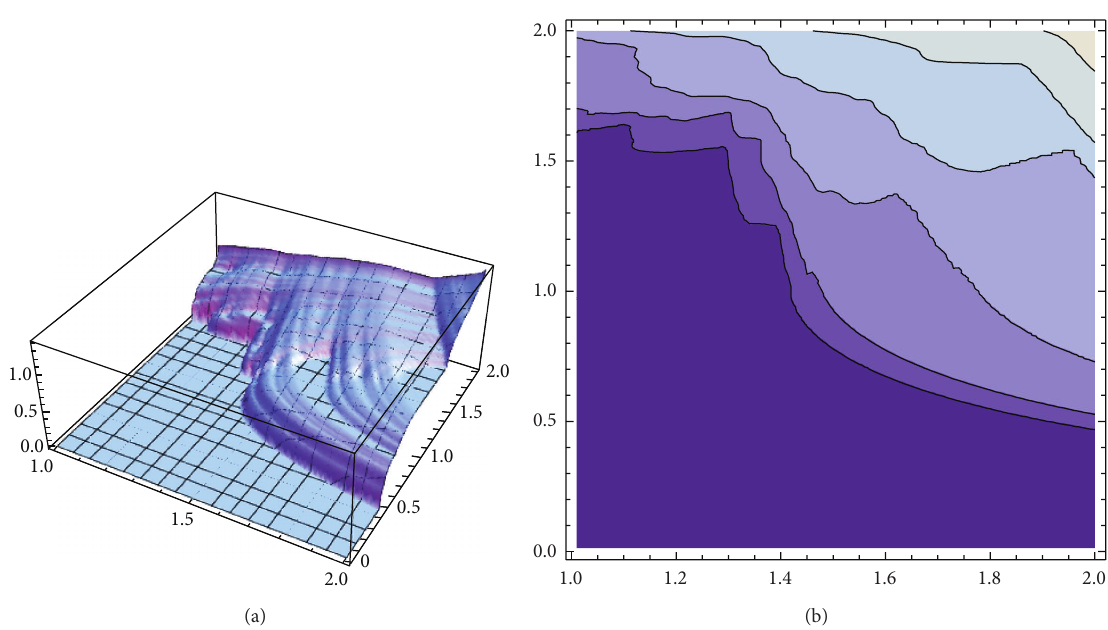
Figure 4: Topological entropy with accuracy 10 −3 for each (𝛼,𝛽) ∈ [1, 2] × [0, 2] , 3D view (a) and projection (b).